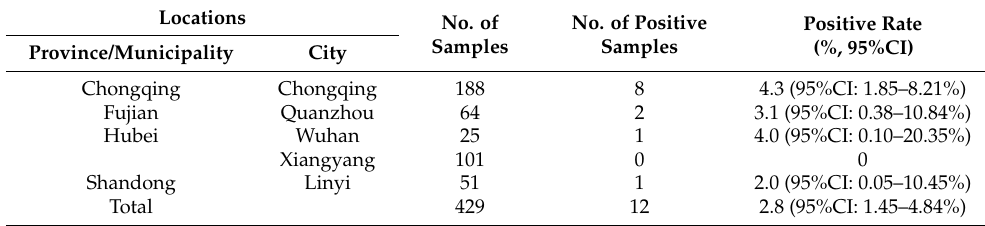
Table 1. Prevalence of Babesia gibsoni in cats in